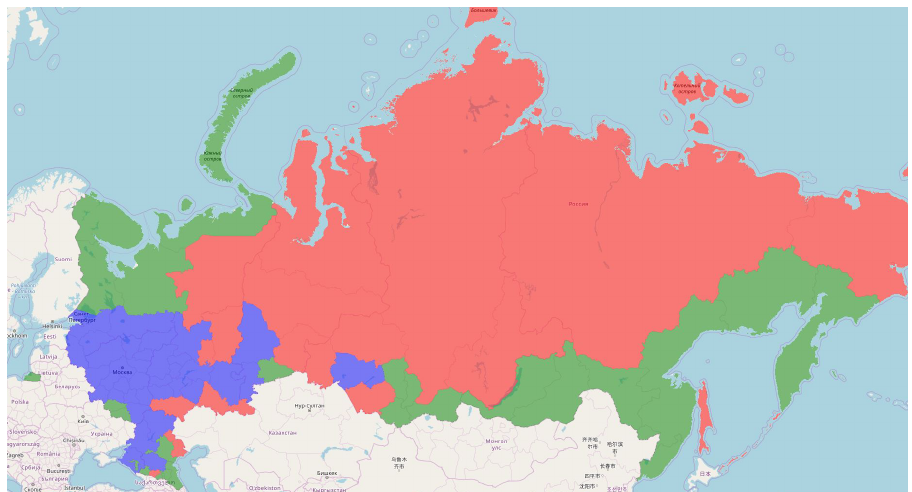
Figure 3. Regions of Russia, clustering by specialization, 2017.